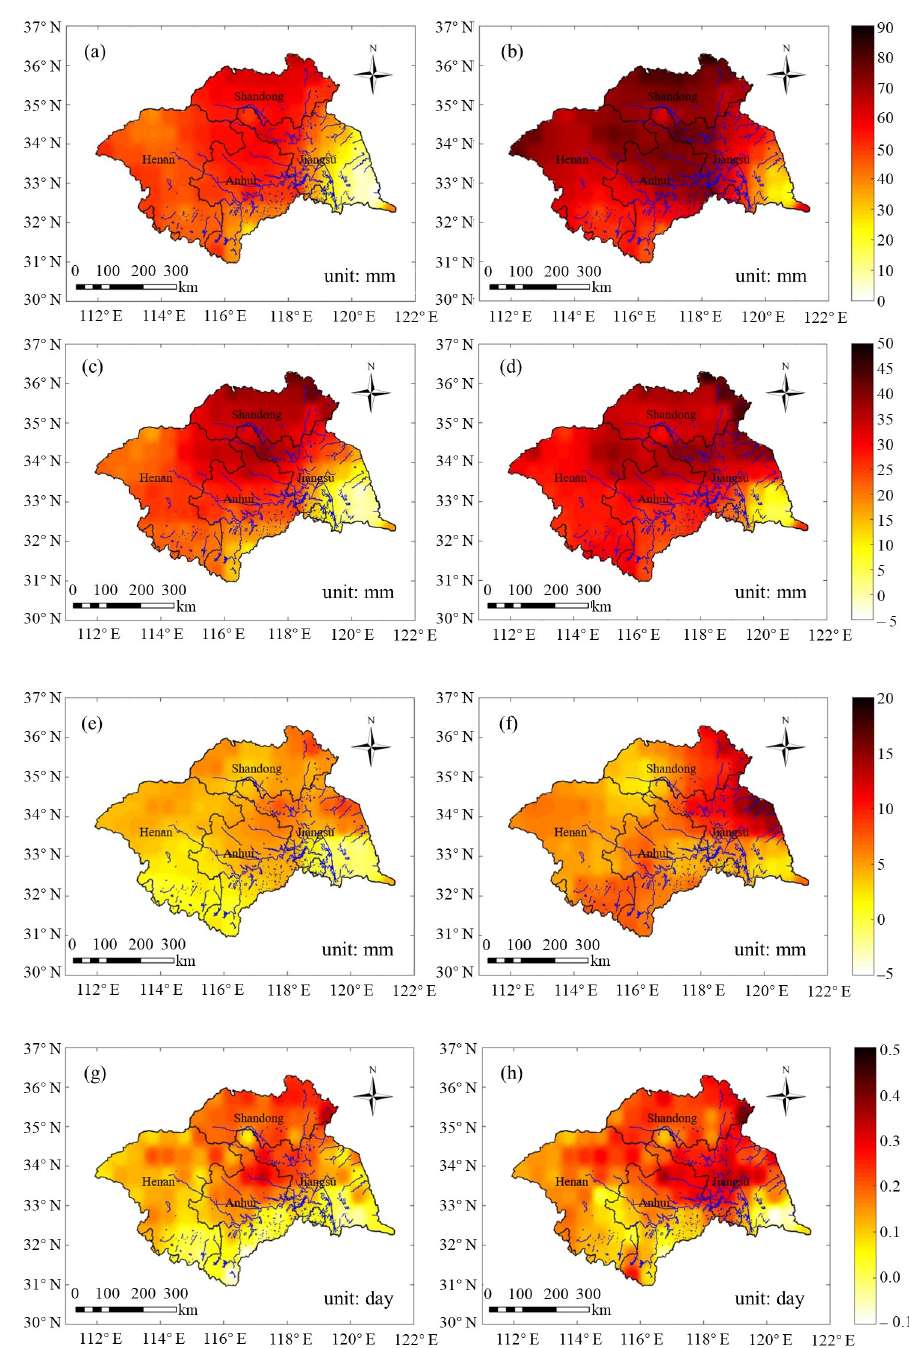
Figure 9. Spatial distribution of changes in AP ( a , b ), R95P ( c , d ), Rx1d ( e , f ), and Rr50 ( g , h ) for the Huai River basin under 1.5 ◦ C and 2.0 ◦ C global warming scenarios (left: changes under 1.5 ◦ C global warming with the number of a , c , e , and g from top to bottom; right: changes under 2.0 ◦ C global warming with the number of b , d , f , and h from top to bottom).